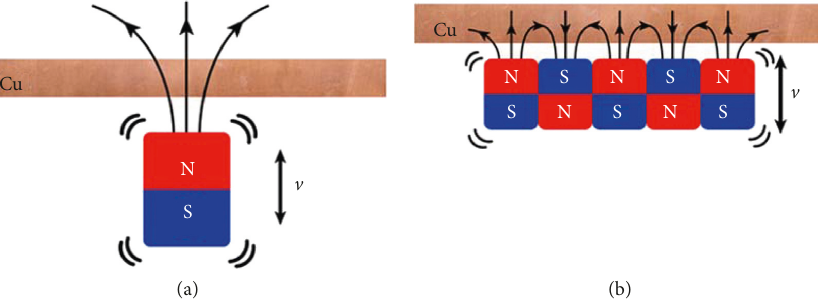
Figure 3: ECD common configurations: (a) Single magnet against conductive element. (b) Multipole magnets against conductive